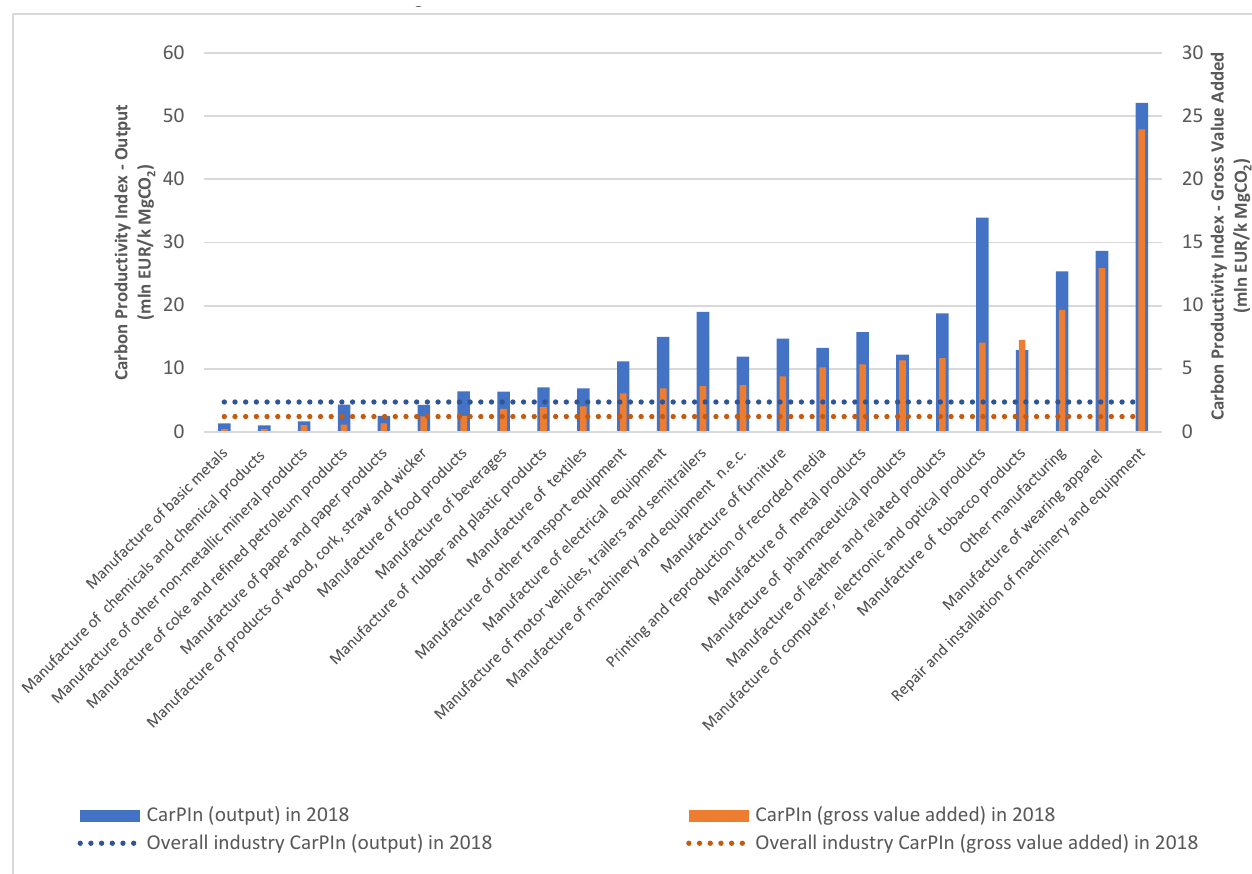
Figure 6. Carbon Productivity Index (million EUR/k Mg CO 2 ) in 2018 (own study).